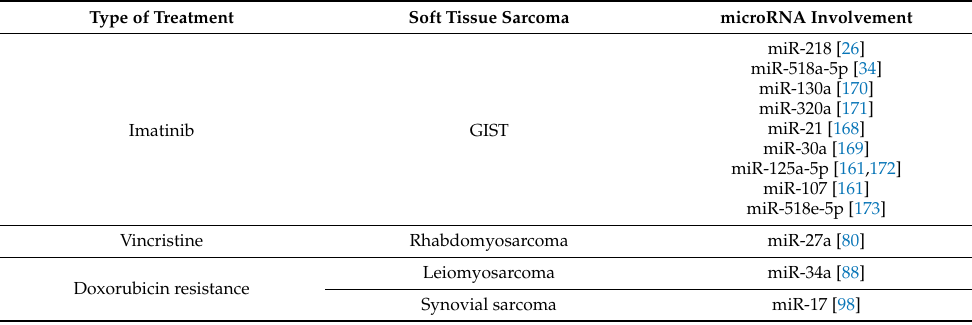
Table 3. miRNAs implicated in treatment resistance in soft tissue